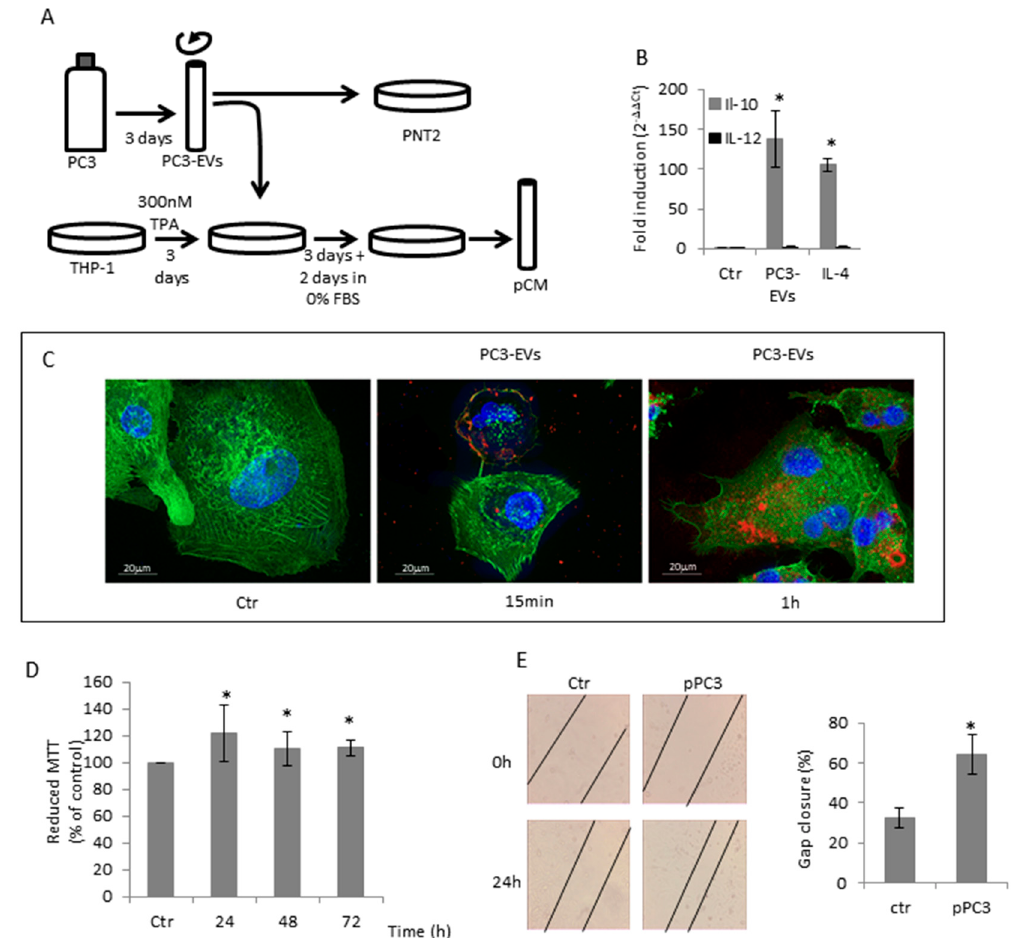
Figure 1. PC3-secreted EVs induced TAM-like polarization in THP-1 di ff erentiated macrophages. ( A ) Diagrammatic representation of treatments. ( B ) TPA-di ff erentiated THP-1 cells were exposed to 100 µ g / mL PC3-Evs or 20 ng / mL IL-4 for 6 h and IL-10 and IL-12 gene expression was assessed by qRT-PCR. Gene expression values were normalized to HPRT and presented as 2 − ∆∆ Ct . Relative mRNA gene abundance in untreated cells (Ctr) was assumed as 1. Data represent mean ± SD ( n = 6). * p < 0.05 vs. control cells. ( C ) TPA-di ff erentiated THP-1 cells were exposed to 100 µ g / mL DiD’-stained PC3-Evs. At the indicated time points, cells were fixed, actin filaments stained with FITC-labelled phalloidin and nuclei were counterstained with DAPI. The images are representative of one out of three separate experiments. Magnification 63 × . ( D ) PC3 cells were exposed to pCM for the indicated times and cell viability was determined by MTT assay. MTT reduction in untreated cells (Ctr) was assumed as 100%. Data represent mean ± SD ( n = 6). * p < 0.05 vs. control cells. ( E ) PC3 cells were grown to confluence, scratched and exposed to pCM. The rate of migration was measured by quantifying the distance between the edges of the scratch. The width of the gap at time 0 was considered to be 100% and was used to calculate the % of gap closure (reported in the graph). Data represent the mean ± SD ( n = 3). * p < 0.05 vs. control cells.